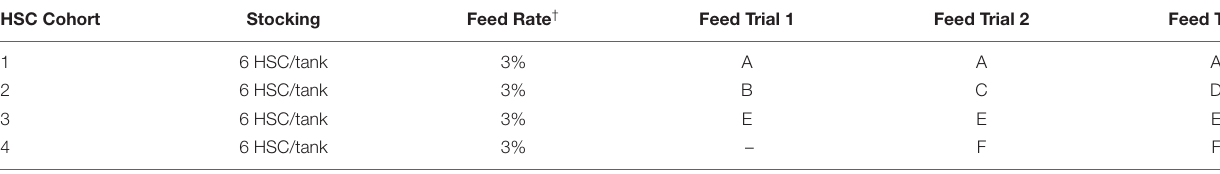
TABLE 1 | Feed trial and respective cohort diets.